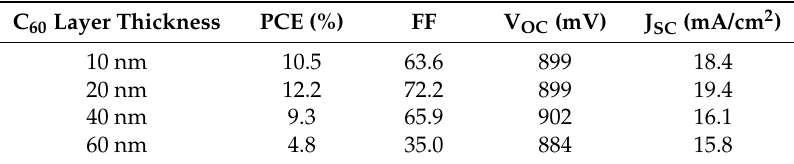
Table 2. Annealing effect of C 60 layer.